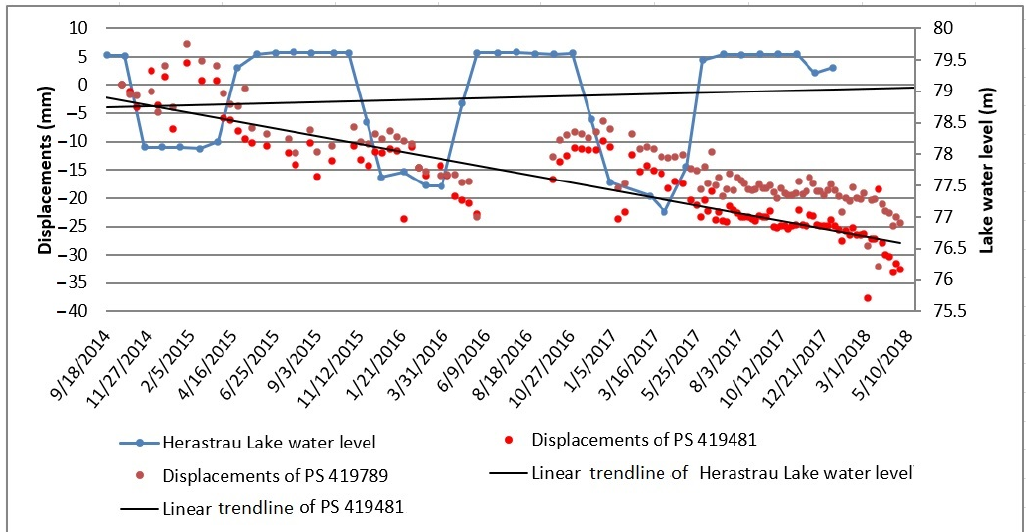
Figure 11. Comparison between the Her ă str ă u Lake water level and the evolution of the land vertical displacements in Soseaua Nordului area. Source: elaborated by the authors.